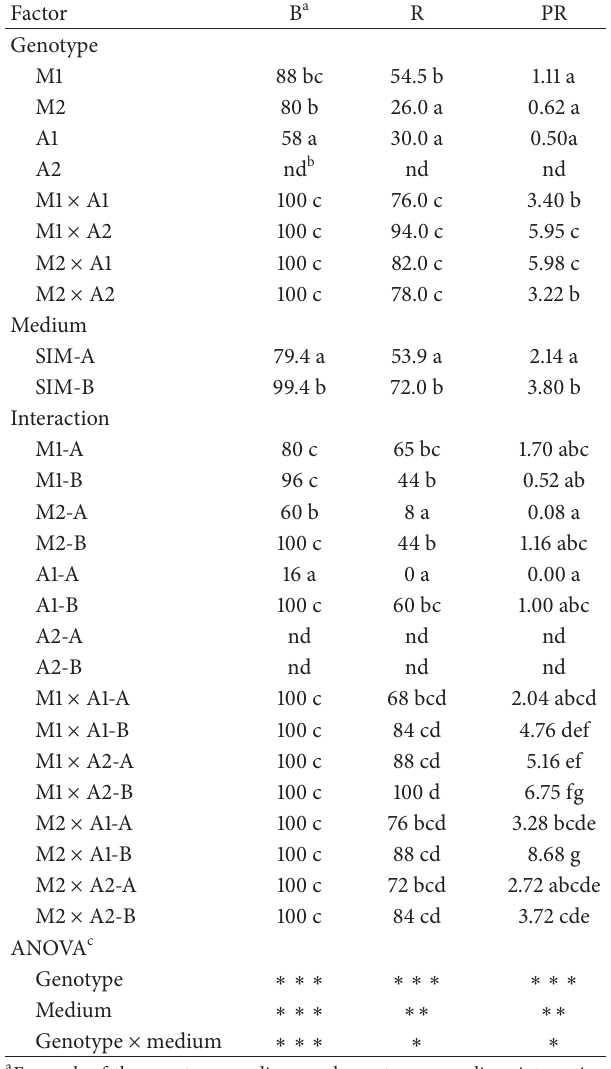
a For each of the genotype, medium, and genotype × medium interaction factors, mean values within a column separated by different letters are significantly different ( 𝑃 < 0.05 ) according to Duncan’s multiple range test. b